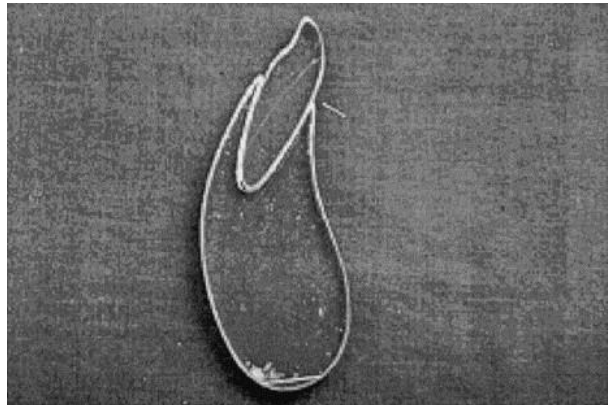
Figure 5. Model of tooth and supporting bone for photoelastic stress analysis. Strain gauge and photoelastic analysis of in vivo strain and in vitro stress distribution in human dental supporting structures. Adapted with permission from Ref. [92]. 2019, Elsevier.